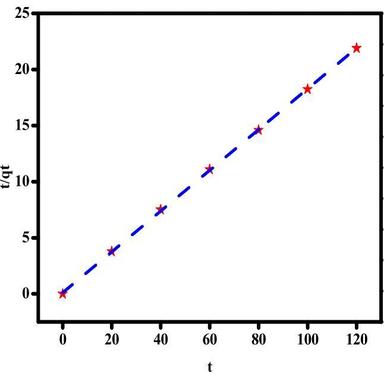
Kinetic study.